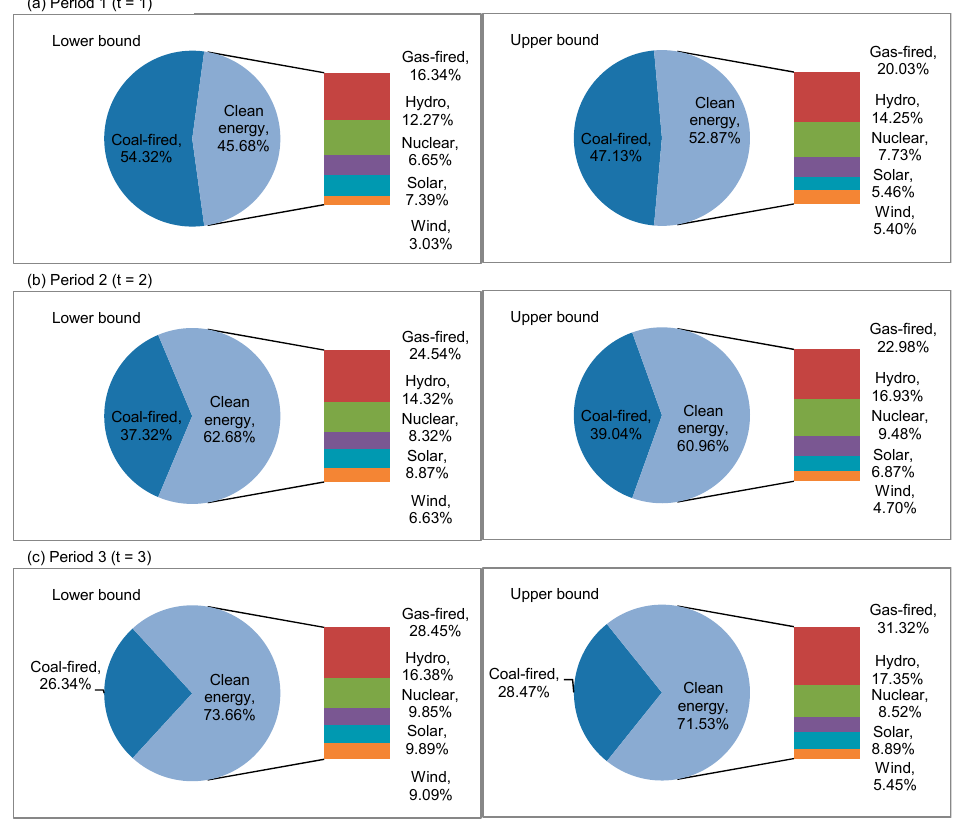
Figure 4. Distribution of electricity generation in each period: ( a ) period 1 ( t = 1); ( b ) period 2 ( t = 2); ( c ) period 3 ( t = 3).